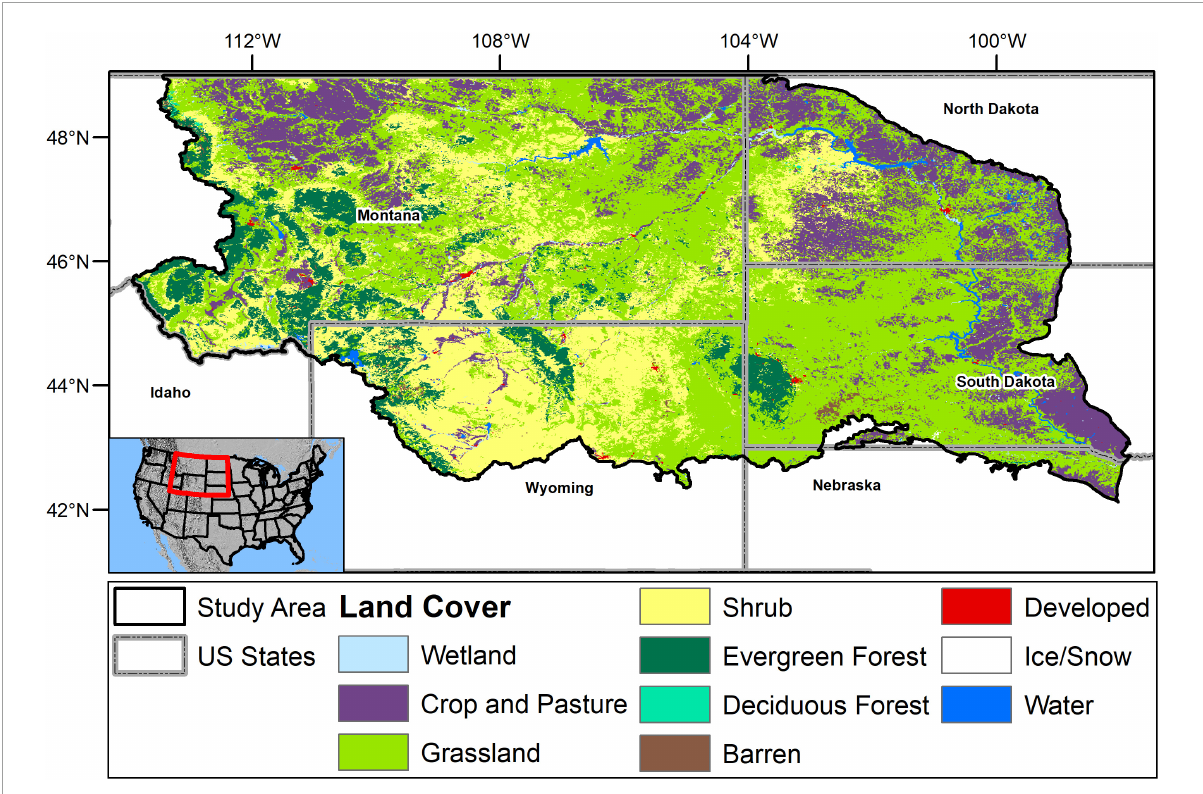
FIGURE1 The U.S. Northwestern Plains, as defined by Level 3 Ecoregions (Omernik, 1987) and land cover from 2013 as mapped in the National Land Cover Database (Wickham et al., 2014). The study area includes the Northwestern Great and Glaciated Plains (Level 3) Ecoregions, plus portions of the Wyoming Basins and Middle Rocky